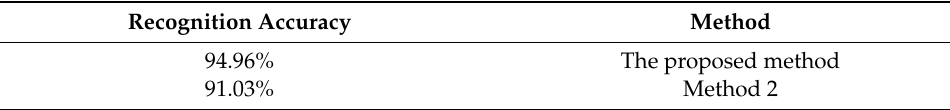
Table 3. The average recognition accuracy of two methods.